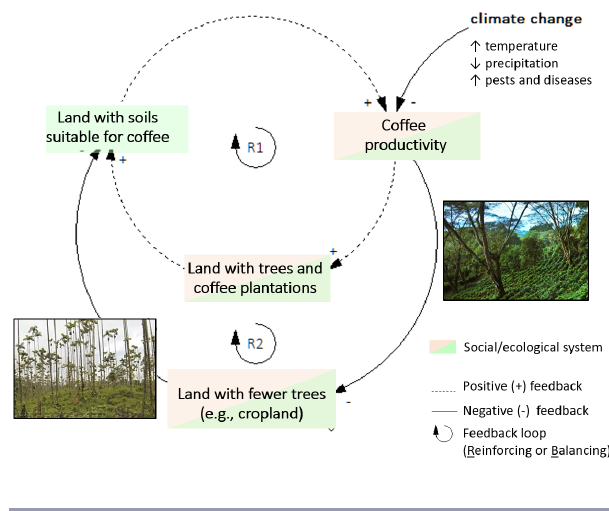
Fig. 4 . Causal loop diagram for shaded coffee plantations that are changed to other land uses without trees due to the impacts of climate change. R = reinforcing feedback loop, in which changes are exacerbated and result in even more changes in the system; B = balancing feedback loop, in which changes are buffered and result in fewer changes in the